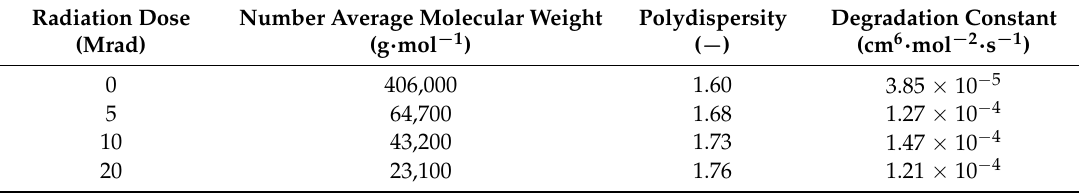
Table 3. Initial properties of the polymer analyzed through mathematical modeling and degradation kinetic constants obtained through experimental data